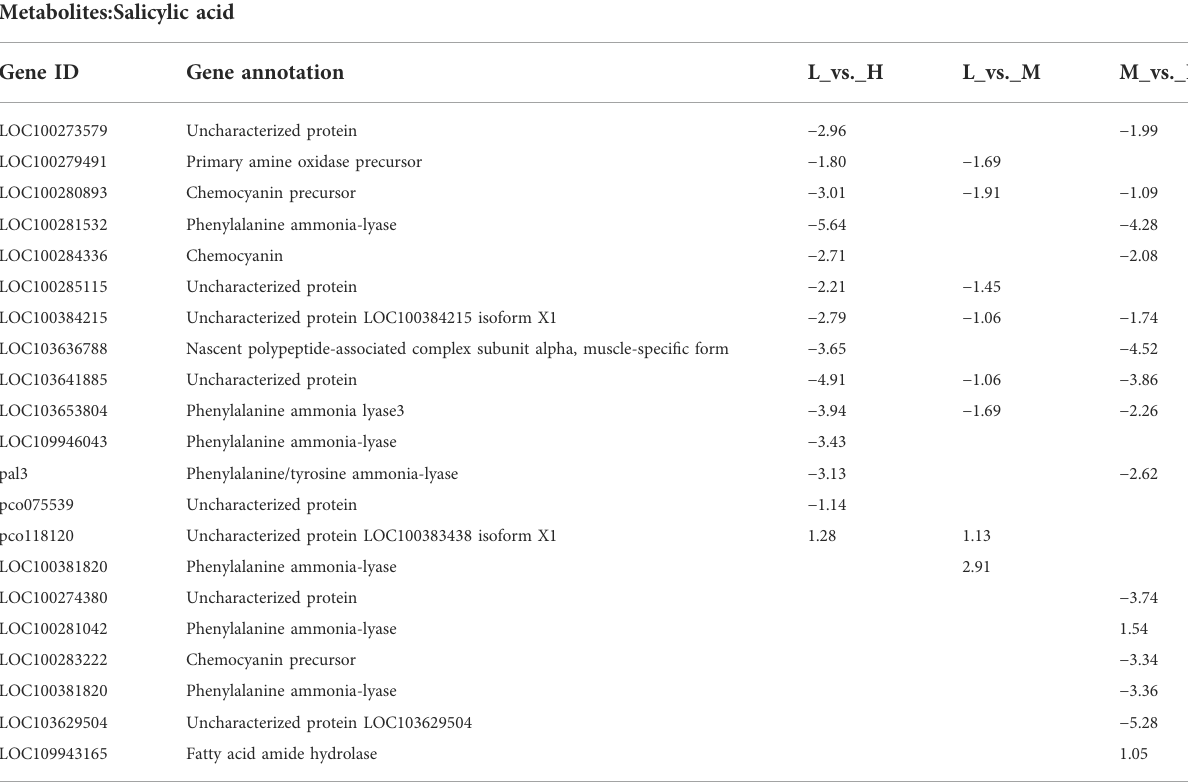
TABLE 1 Annotation of DEGs associated with plant hormone – related metabolites regulating stalk lodging resistance in maize. Pathways:Phenylalanine